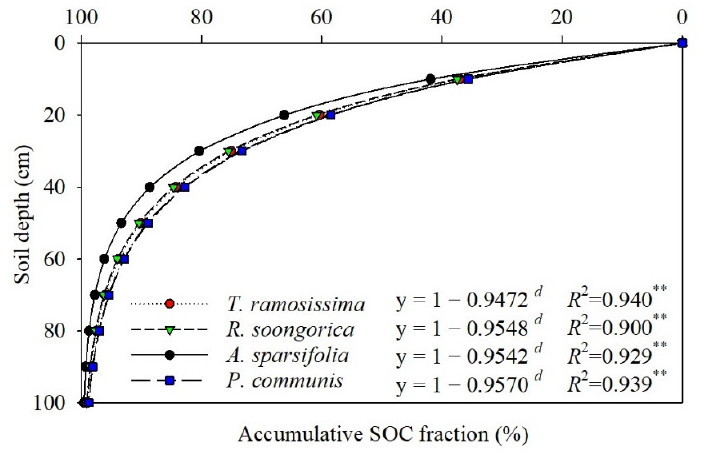
Figure 6. Asymptotic single − parameter global model of the vertical distribution of soil organic carbon (SOC) of the five plant communities in 0–100 cm. Note: d , soil depth (cm); Significance levels: **, p < 0.01. Table 2. Changes in the soil organic carbon (SOC) content over time (mean ± SD).